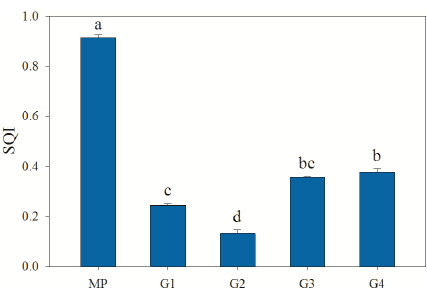
Figure 5. Soil quality index in the Pinus and the successive Eu- calyptus plantations. MP, G1, G2, G3 and G4 refer to the Pinus plantation and the first, second, third and fourth generation Euca- lyptus plantations, respectively. SQI, soil quality index. SQIs with the same letter are not significantly different at p